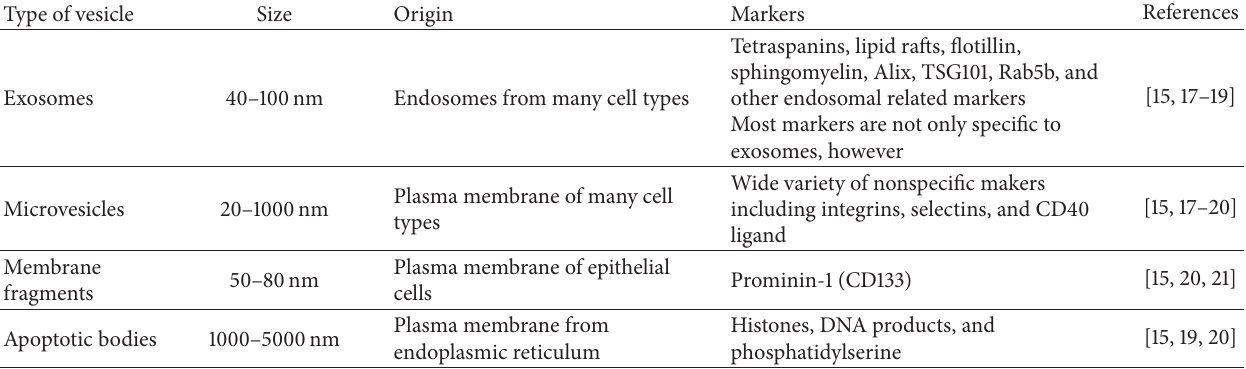
Table 1: Classification of extracellular vesicles basis on their cellular